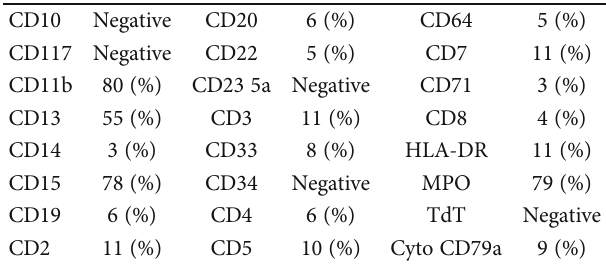
Table 1: Postoperation fl ow